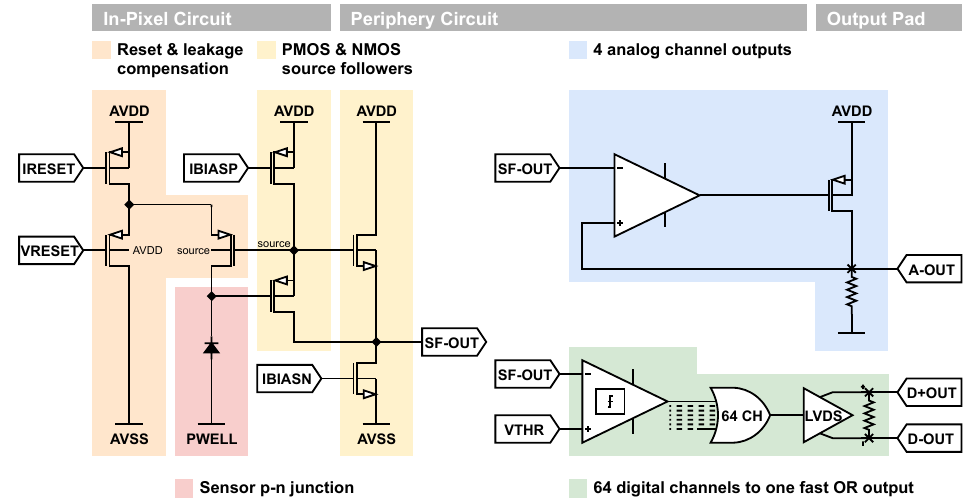
Figure 3. On-chip readout